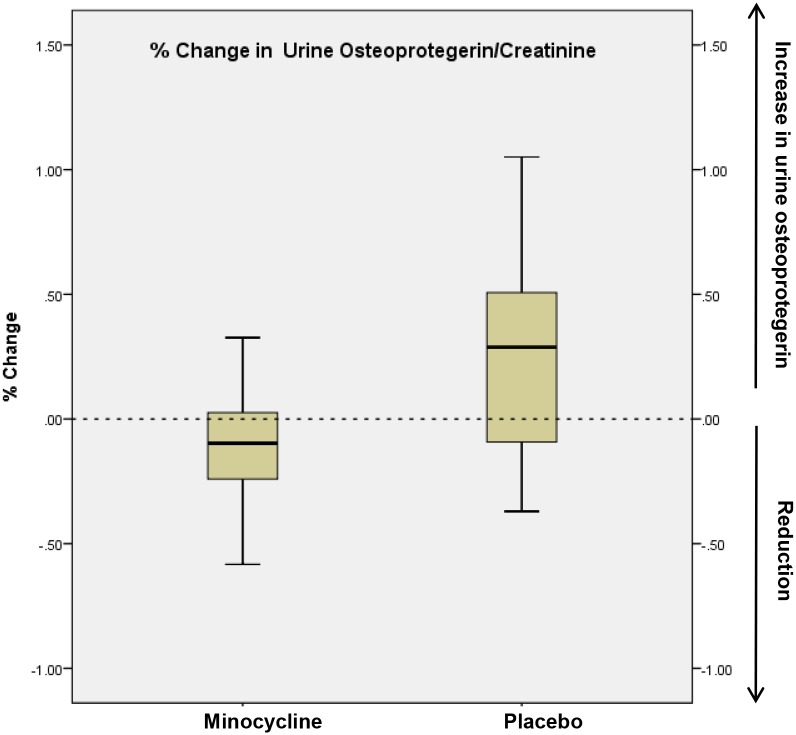
% change in 24-hour urine osteoprotegerin: creatinine measurements from baseline to 6 months in placebo and minocycline groups.The edges of the boxes represent the 25% and 75% percentiles, the middle lines represents the median, and the whiskers extend to the minimum and maximum values. The %change in urine osteoprotegerin: creatinine was significantly lower in the minocycline group vs. the placebo group (mean % change -0.09 vs. 0.25, P = 0.046).